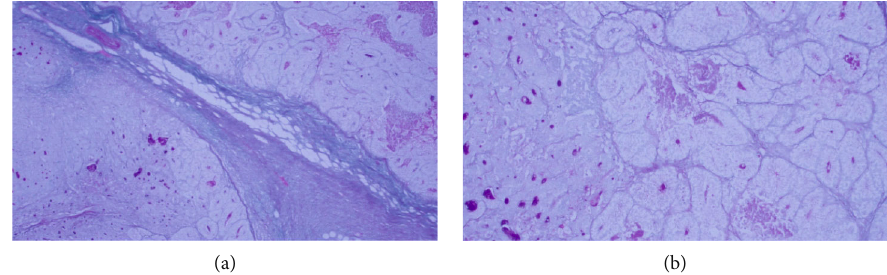
Figure 6: Alcian/PAS staining was negative in the tumor cells of the clear component: (a) 40 × ; (b) 100 × .